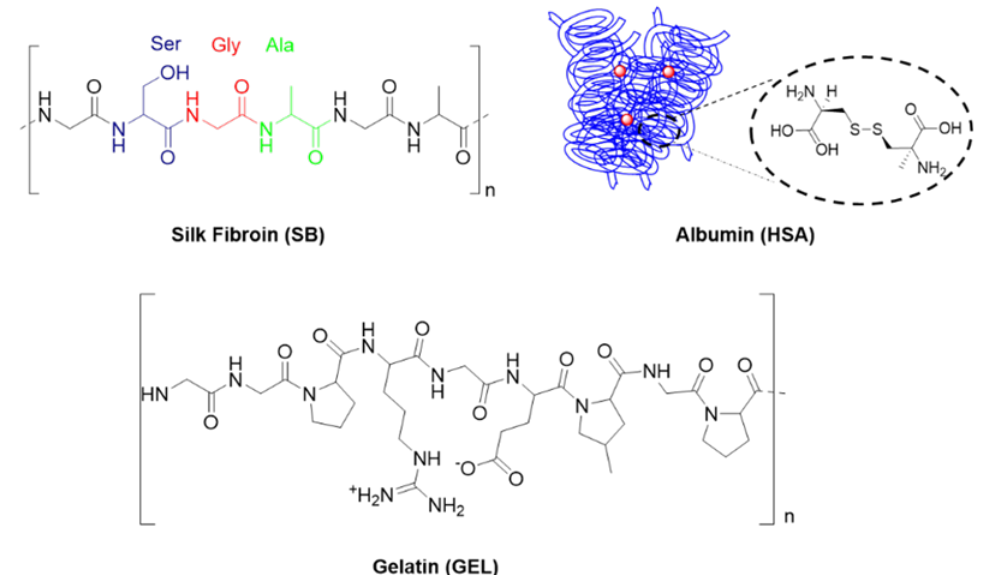
Figure 7. Chemical structure of proteinaceous biopolymers.